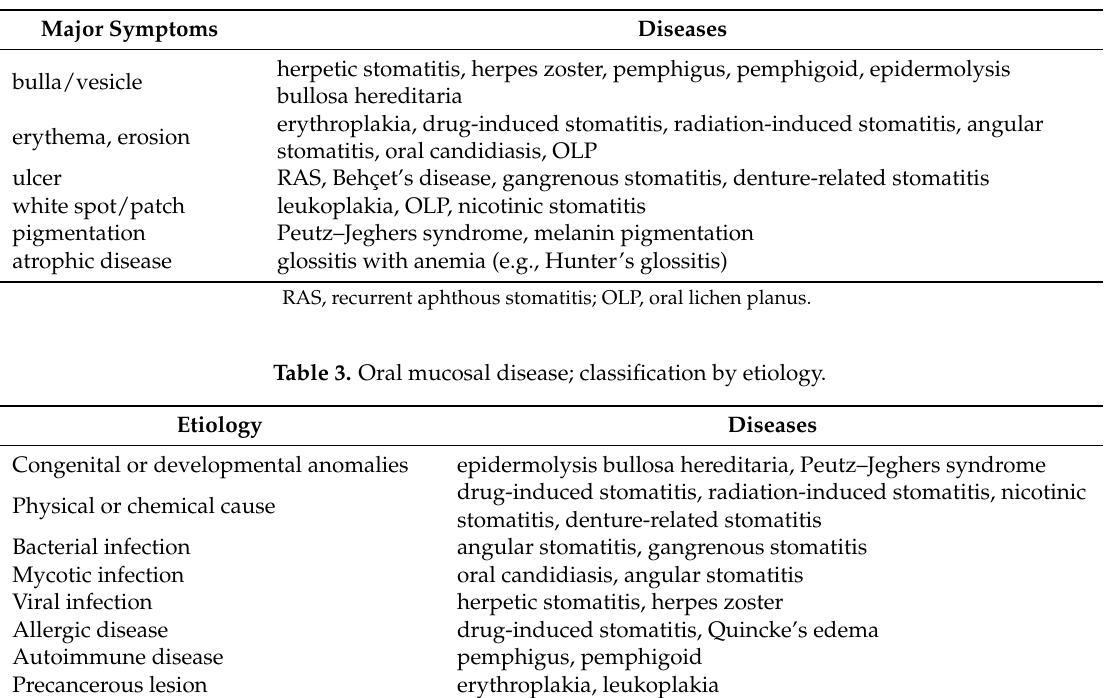
Table 2. Oral mucosal disease; classification by clinical manifestations.